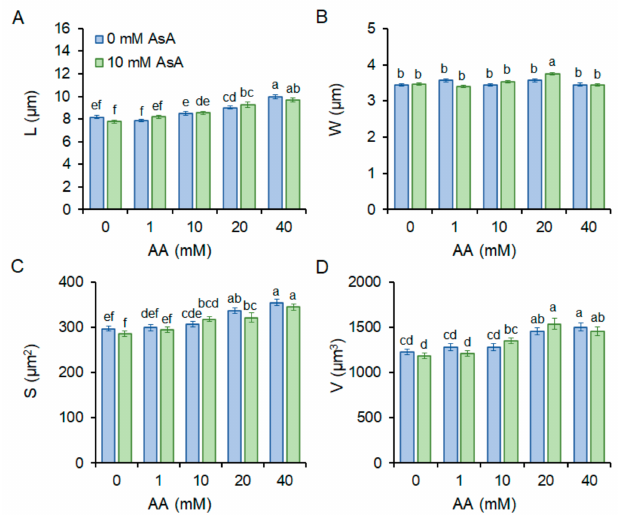
Figure 2. Cell morphology. Length ( A ), width ( B ), surface ( C ), and volume ( D ) were determined in S. pombe cells upon addition of indicated AA concentrations, with (green bars) and without (blue bars) AsA pre-treatment. Different letters above bars indicate statistical significance of four independent experiments. Each bar with tick represents mean value ± standard deviation (SD) ( n = 100). Statistical significance is determined by Duncan’s post-hoc test, different letters above bars indicate statistical difference at a 0.05 level of